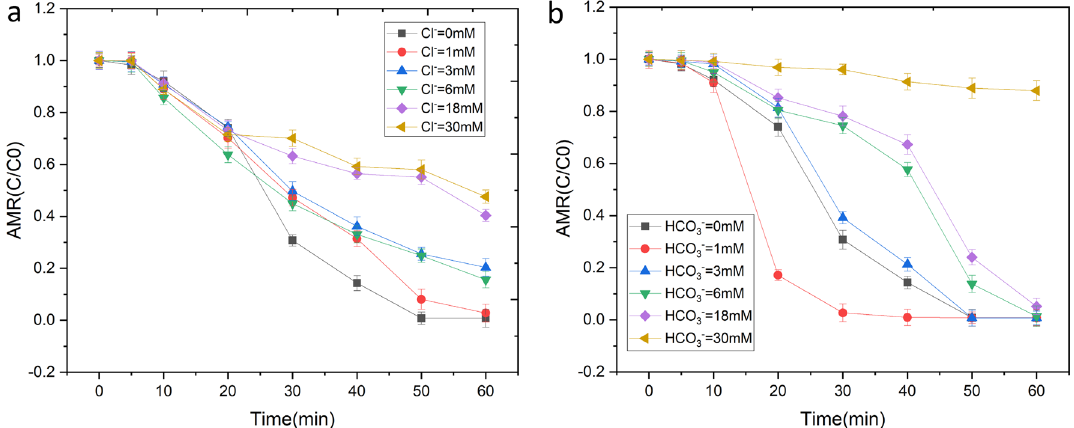
Fig. 5 a Effect of chloride ions on AMR degradation in persulfate–ZVI system. b Effect of bicarbonate on AMR degradation in persulfate–ZVI chloride ions system.